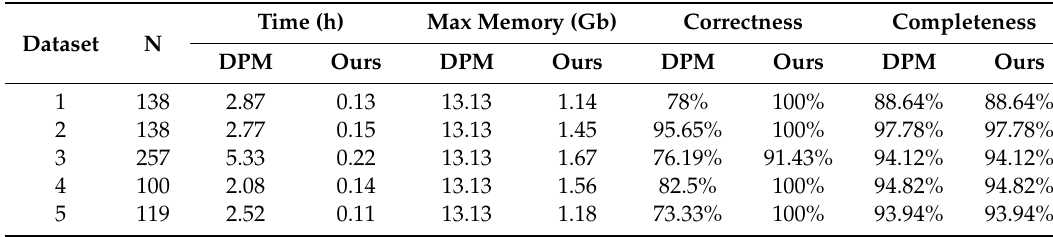
Table 2. Pylon detection